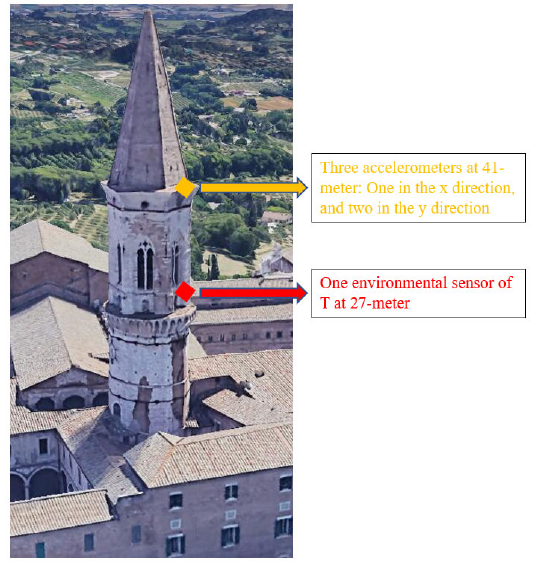
Figure 5. Side view (map data ©2022 Google) and sensor configuration.